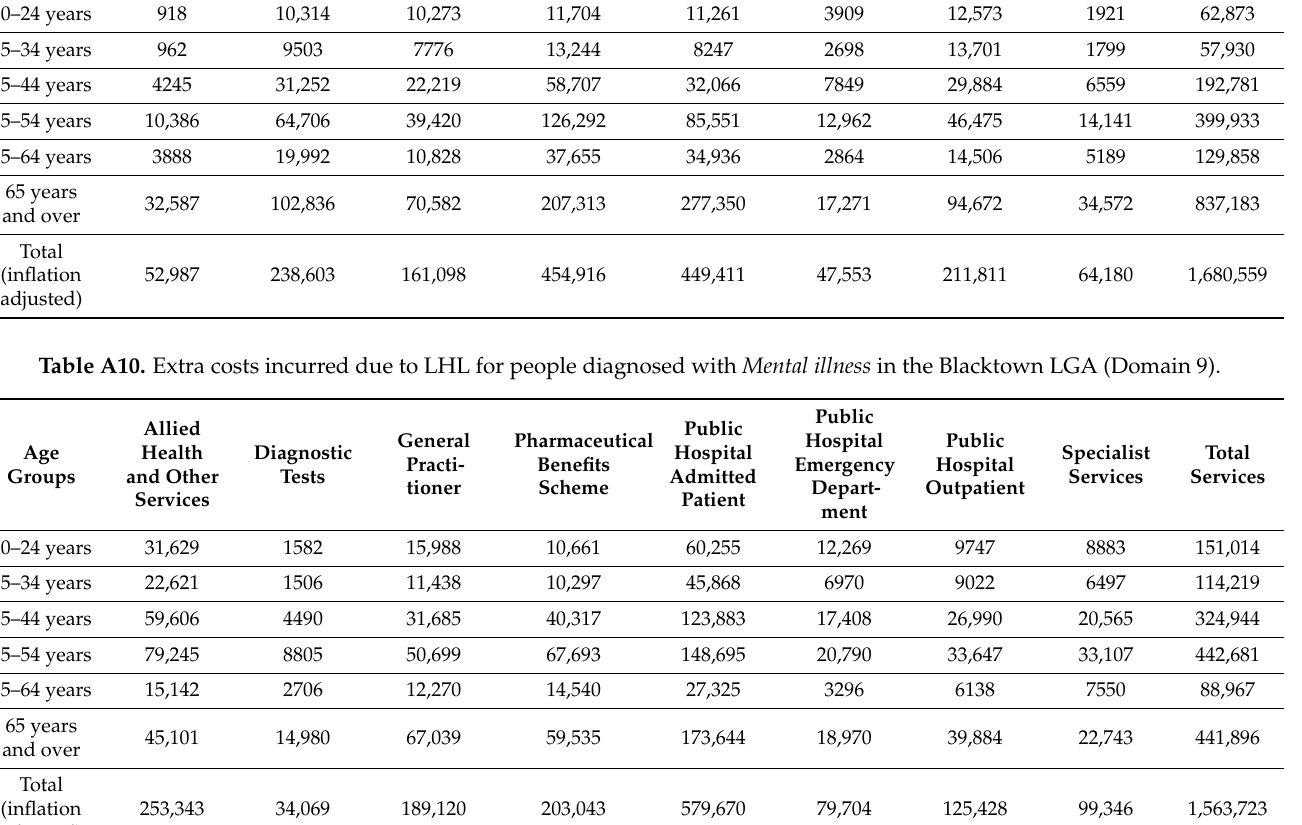
Table A11. Extra costs incurred due to LHL for people diagnosed with Cancer in the Blacktown LGA (Domain 9).